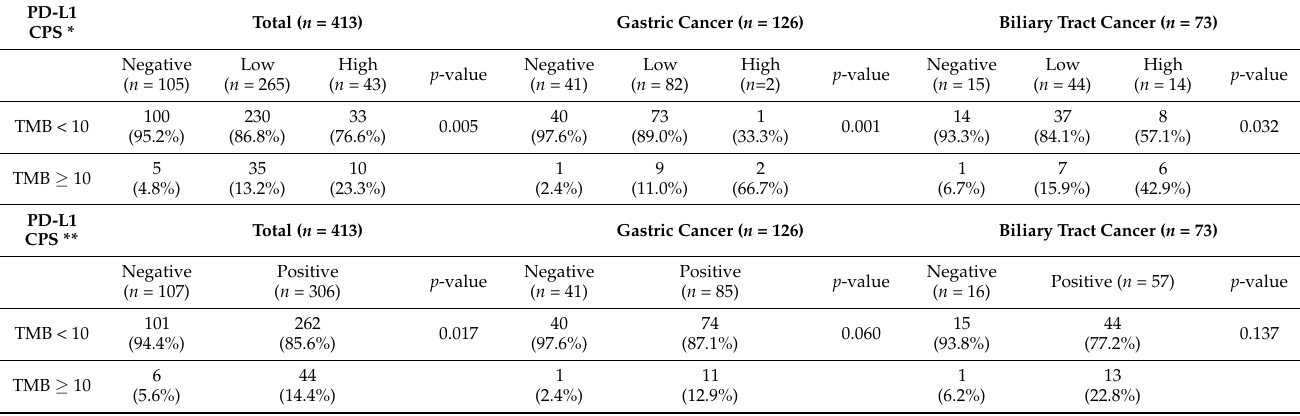
Table 2. Correlation of PD-L1 combined positive score (CPS) with tumor mutation burden (TMB) according to primary